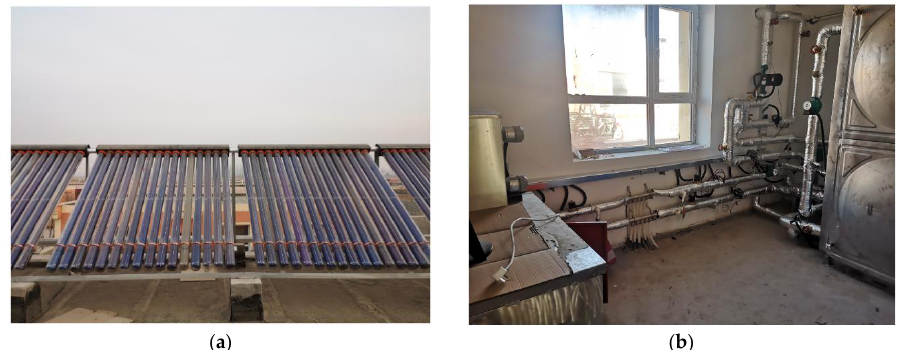
Figure 1. Diagram of MECH system.